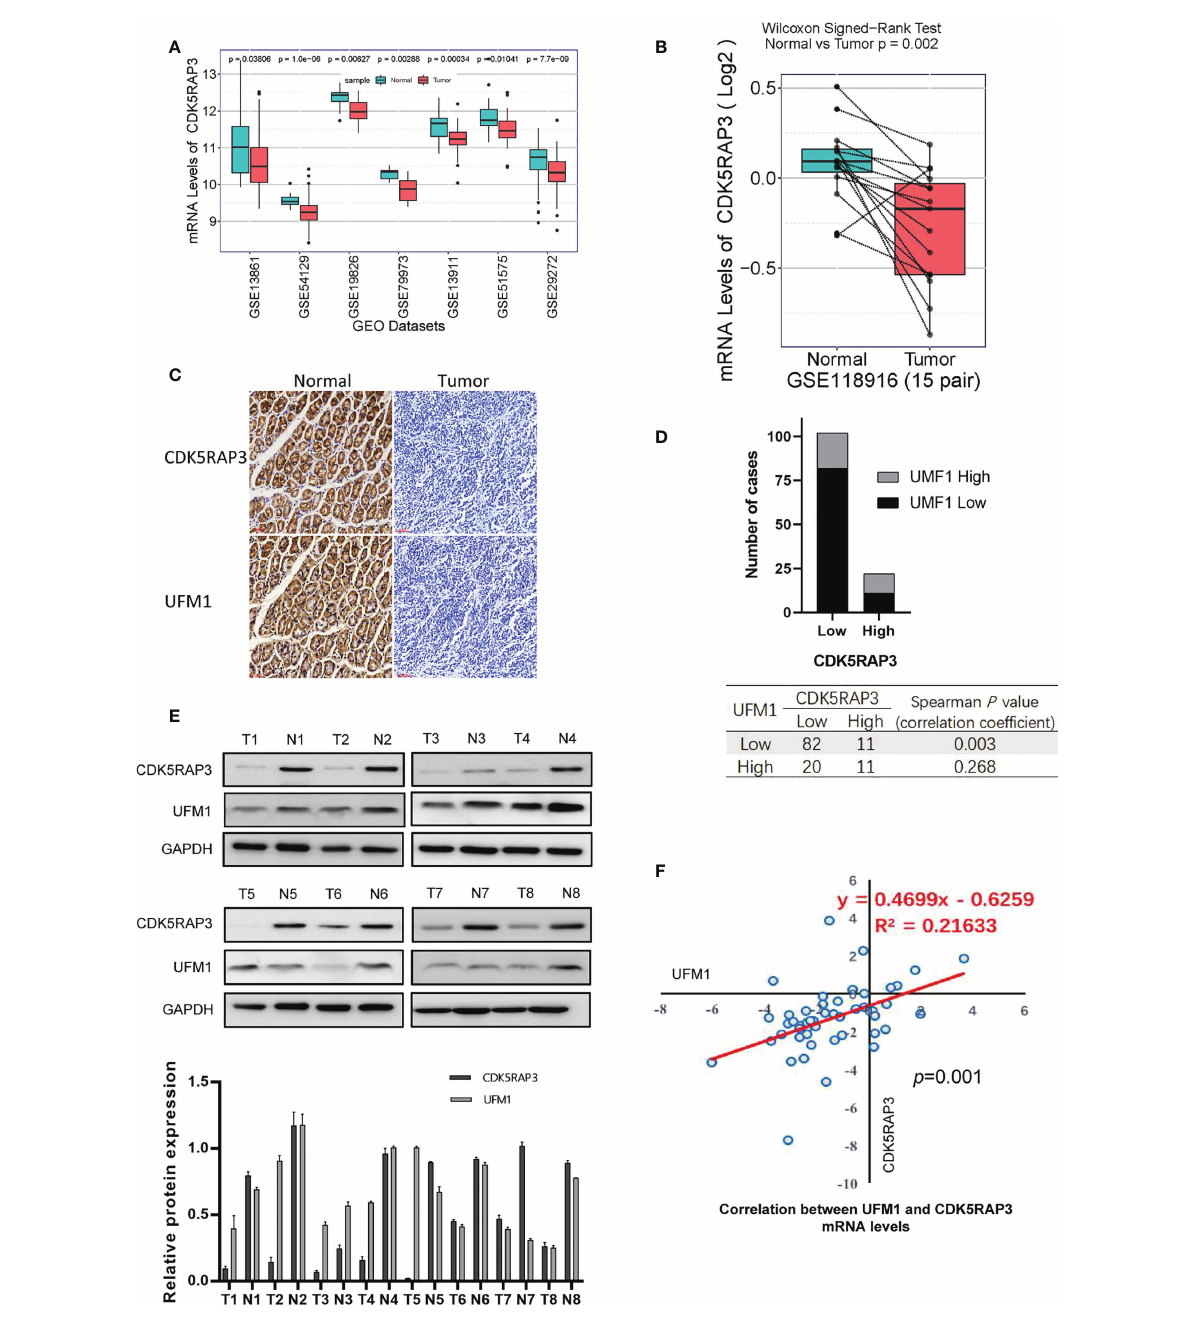
FIGURE 3 Expression levels of CDK5RAP3 and UFM1 in gastric cancer tissue. (A) mRNA levels of CDK5RAP3 in cancer and paracancerous tissues in 7 GEO databases. (B) mRNA levels of UMF1 in cancer and paracancerous tissues from 15 cases in GSE118916. (C) IHC staining of cancerous and paracancerous tissues from gastric cancer patient. (D) CDK5RAP3 was shown to be correlated with UFM1 expression. (E) Protein expression levels of CDK5RAP3 and UFM1 in gastric cancer and paracancerous tissues by Western blot. (F) Correlation of CDK5RAP3 and UFM1 mRNA expression in the gastric cancer tissues of 48